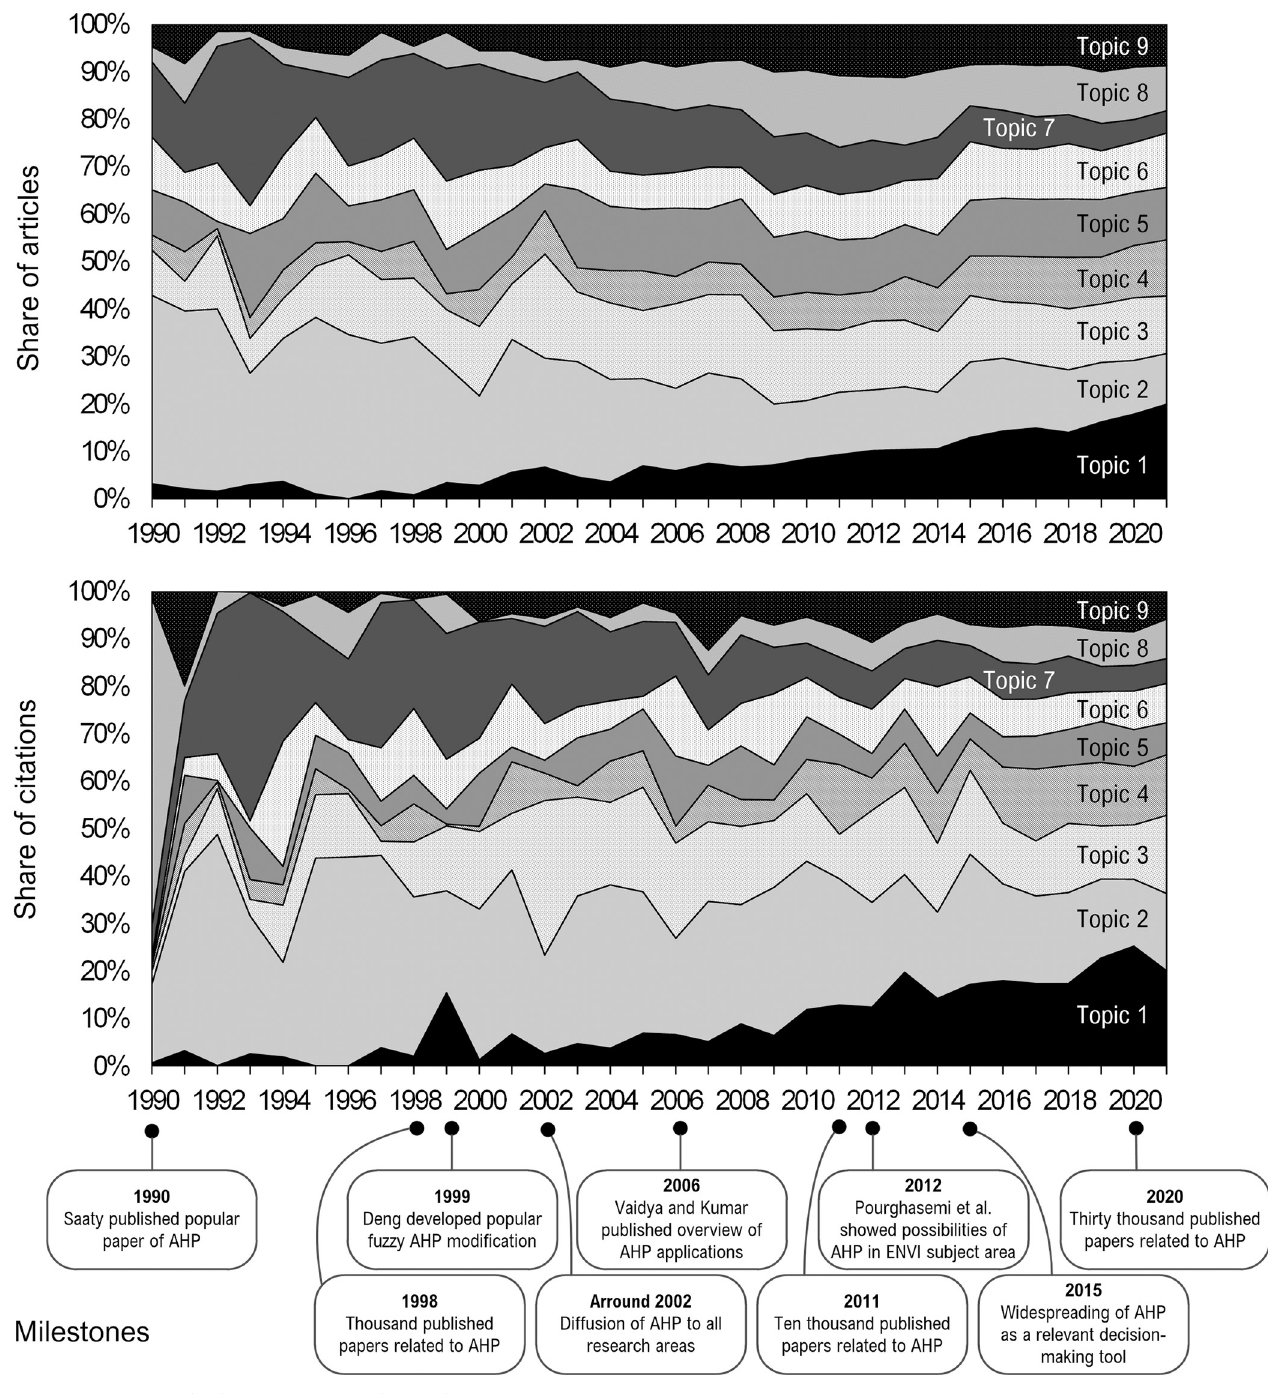
Fig 8. Topic interest (top) and topic impact (bottom)